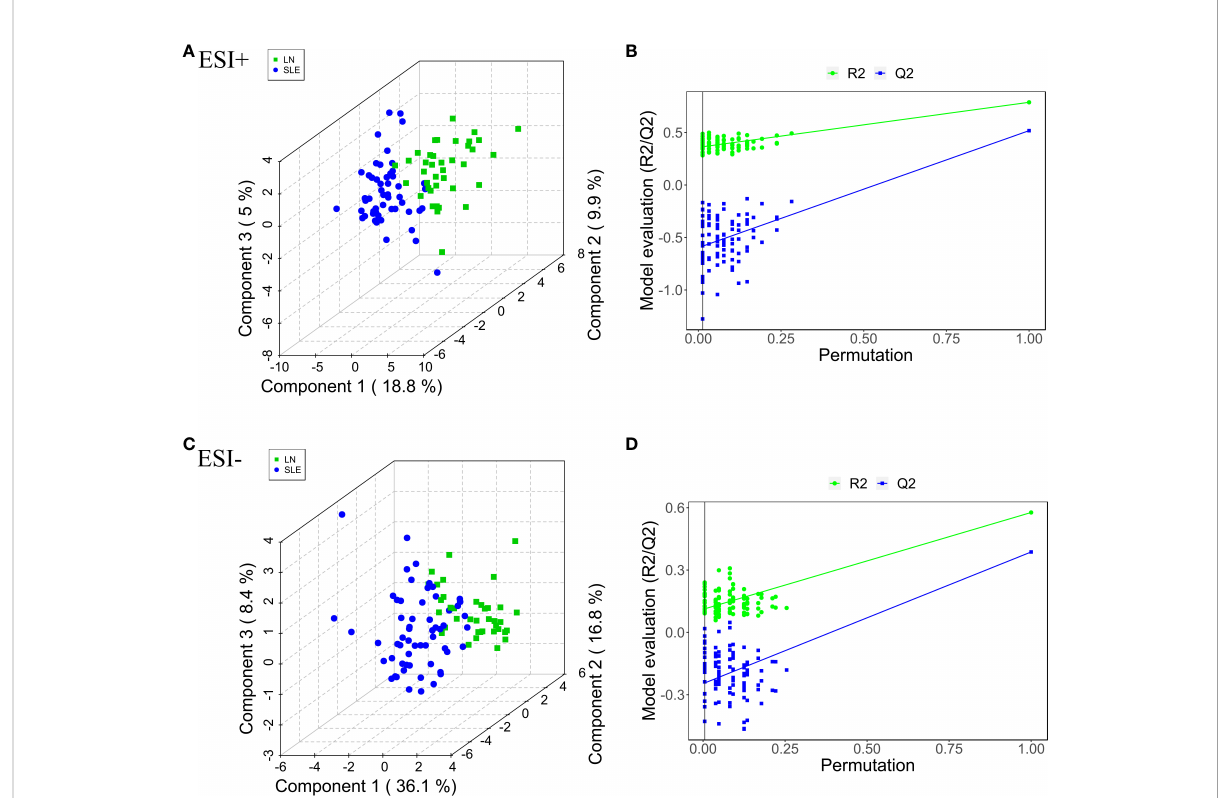
FIGURE 2 Pairwise comparison of the PLS-DA score plots in positive (A) and negative (C) ion modes and permutation test plots in positive (B) and negative (D) ion modes btween SLE and LN groups. The criterion for evaluating whether there is over fi tting in the PLS-DA model is that the regression line at a blue Q2 point crosses or is less than 0 from the abscissa. PLS-DA, partial least squares-discriminant analysis; HC, healthy controls; SLE, Systemic lupus erythematosus; LN, Lupus nephritis.